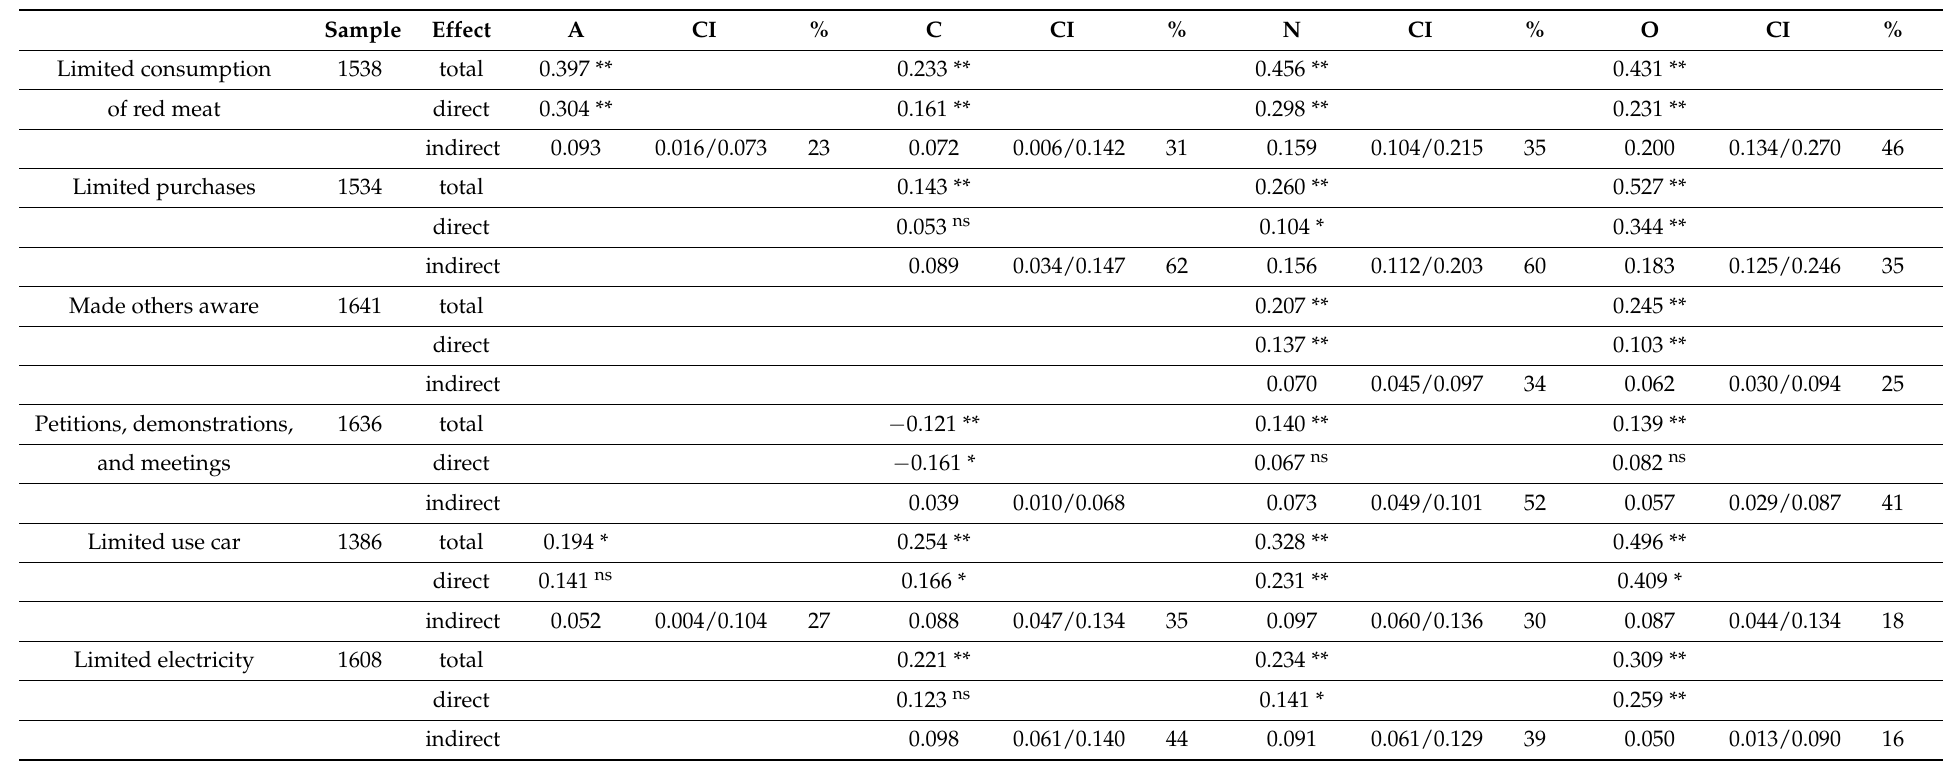
Table 6. Perceived effectiveness as a mediator between personality and mitigation